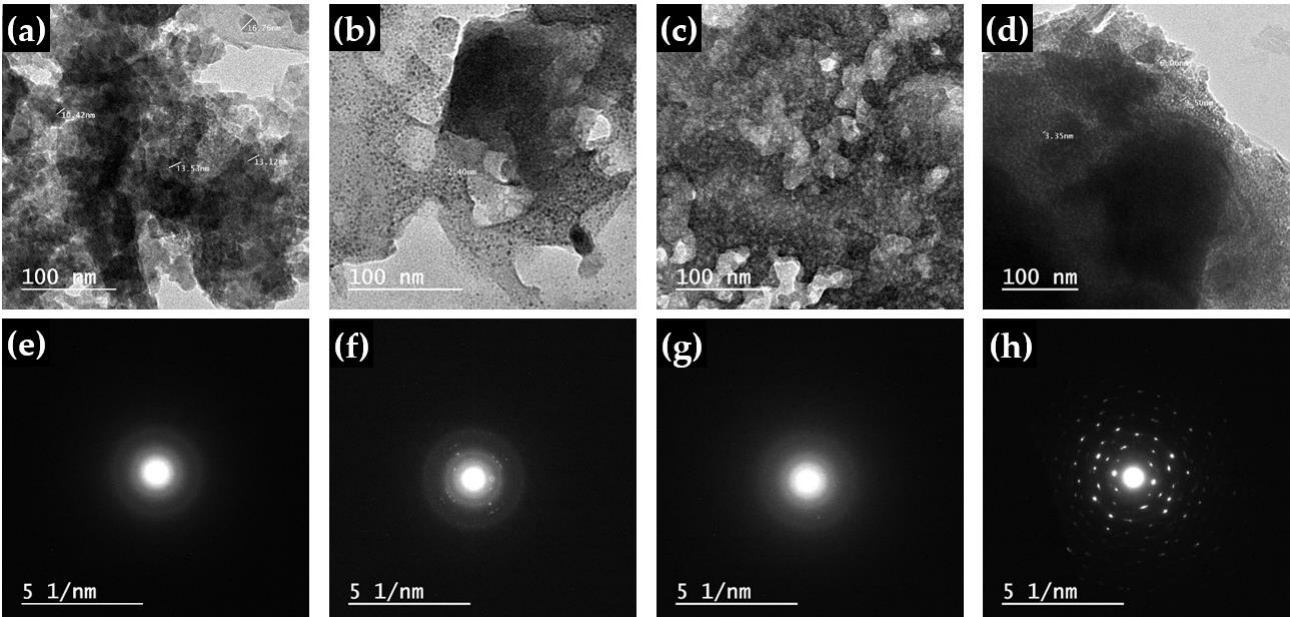
Figure 3. HR-TEM images at high resolving powers, and SAED pattern, respectively, for PbO- x %Al 2 O 3 composites, where x equals ( a , e ) 20%, ( b , f ) 40%, ( c , g ) 60%, and ( d , h ) 100%.